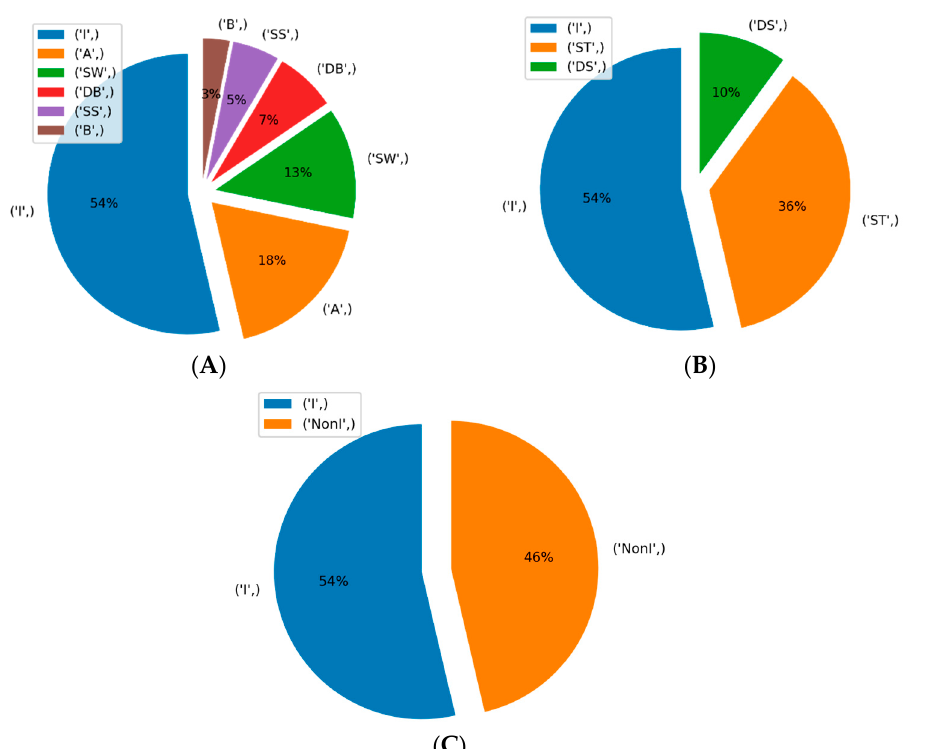
Figure 1. ( A ) Class distribution of flow patterns for six classes; ( B ) Class distribution of flow patterns for three classes (ST stands for segregated flow, ST = SS + SW + A; DS stands for dispersed flow, DS = DB + B; I denotes intermittent flow); ( C ) Class distribution of flow patterns for two classes (Non-I denotes non-Intermittent flow, Non-I = SS + SW + A + DB + B).